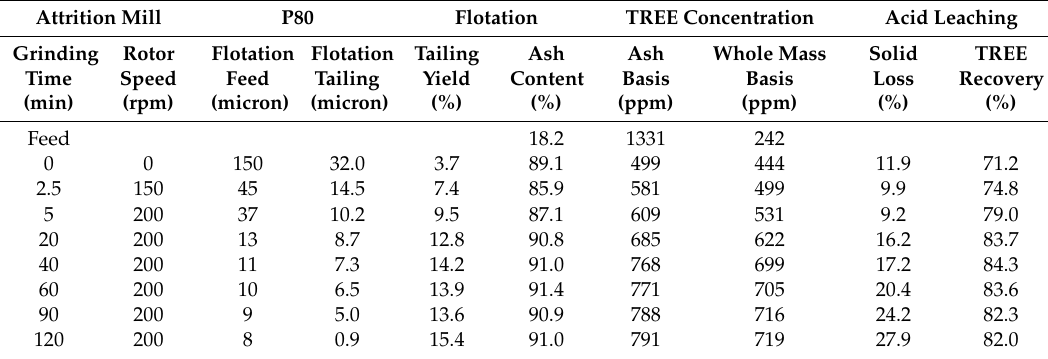
Table 1. Liberation of REEs from the de-carbonized Fire Clay middlings material. Attrition